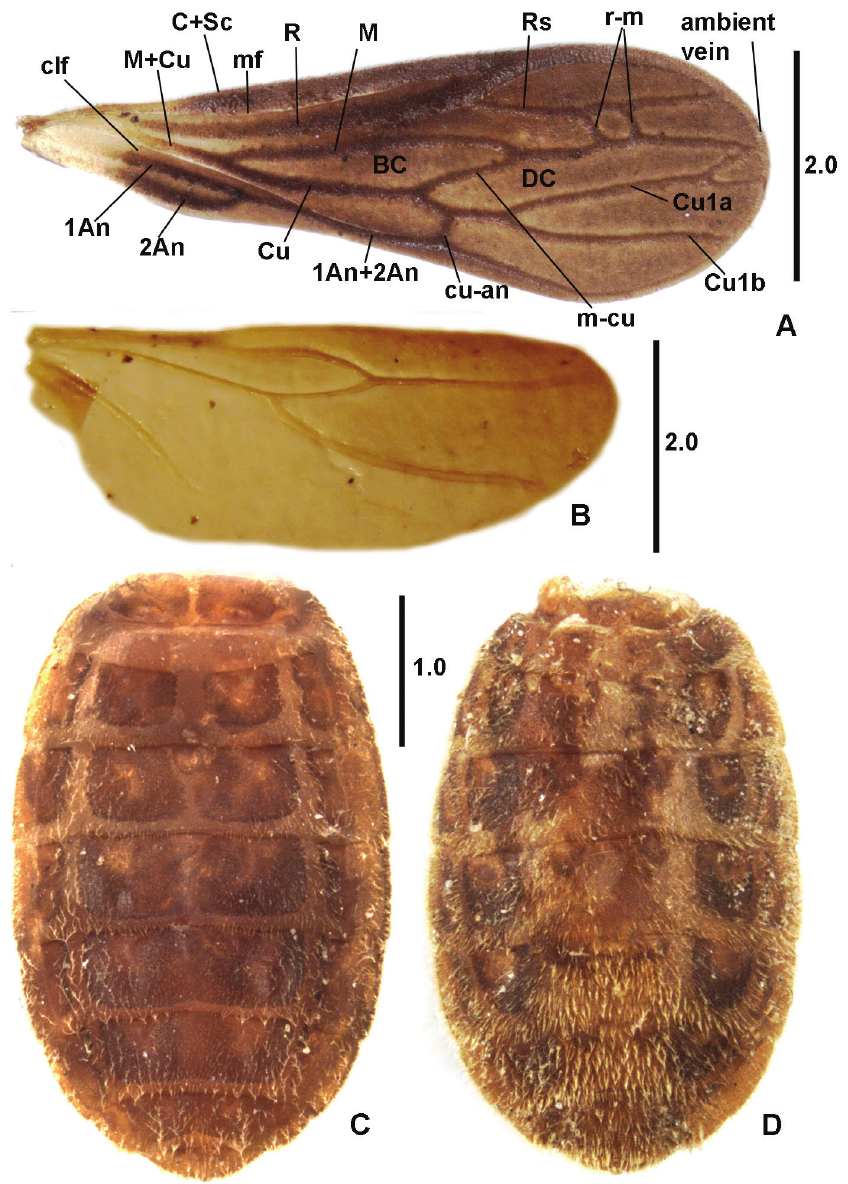
Figure 2. Xenicocephalus tomhenryi sp. n., female holotype A forewing B hindwing C abdomen, dorsal view D abdomen, ventral view. Scale bars in